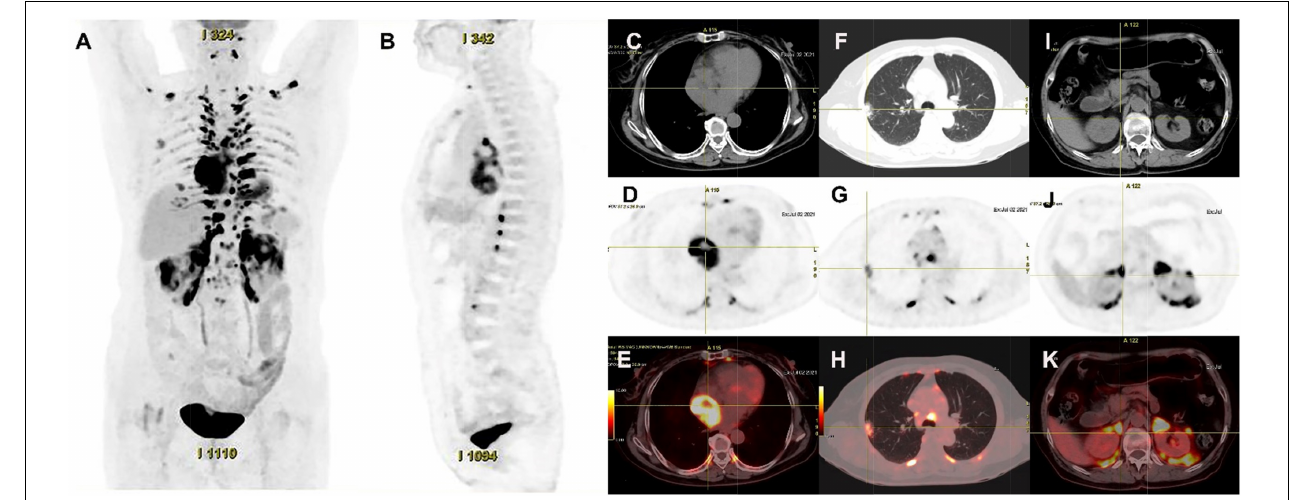
FIGURE 4 | 18 F-FDG PET/CT images of cardiac paraganglioma. (A,B) The whole-body maximum intensity projection showed an intensely hypermetabolic thoracic mass. (C–E) In a cardiac lesion with a high FDG uptake, the SUVmax is about 15.2. (F–H) In the upper lobe of the right lung, a mixed-density nodule with a mild FDG-avid was found near the pleural, with the SUVmax at about 5.8 and a size of about 1.7 cm × 2.3 cm, inflammatory lesions were considered. (I–K) High FDG uptake of brown fat was demonstrated symmetrically along the perirenal and retroperitoneal area with the SUVmax at about 34.4, which was usually caused by the high secretion of catecholamine hormones from paragangliomas.